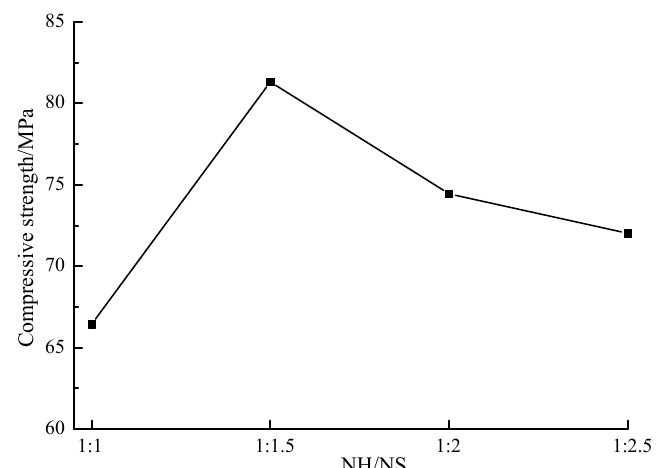
Figure 3. The compressive strength of samples with different NaOH/Na 2 SiO 3 mass ratio. (NaOH = 8 M).